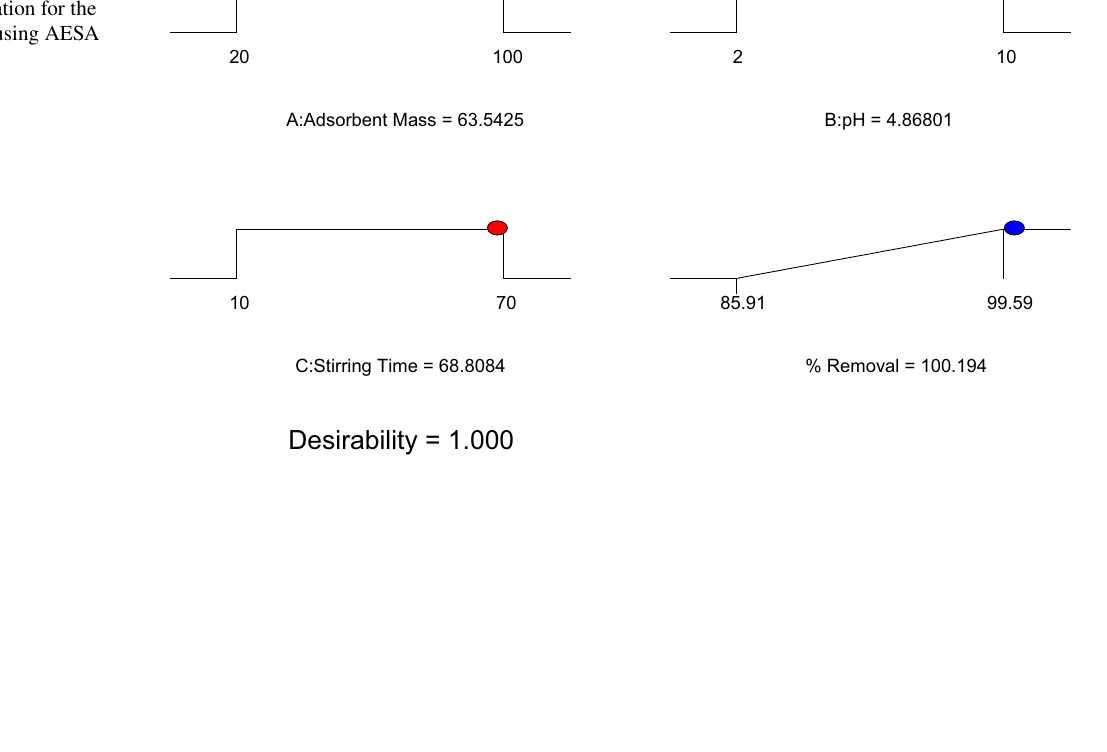
Fig. 18 Desirability ramp for numerical optimization for the selected variables using